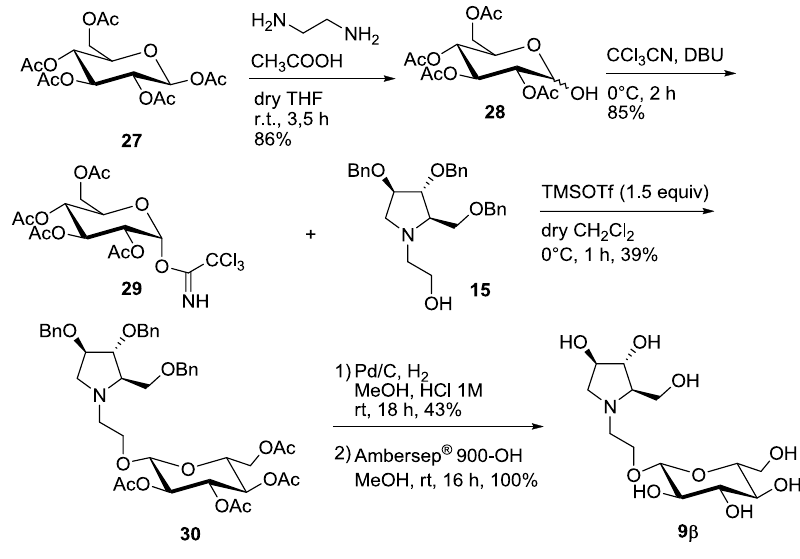
Scheme 4. Synthesis of the pseudodisaccharide 9 β.